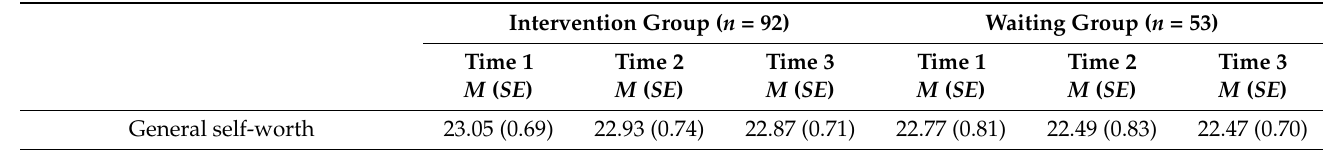
Table 4. Means and standard errors of general self-worth in each